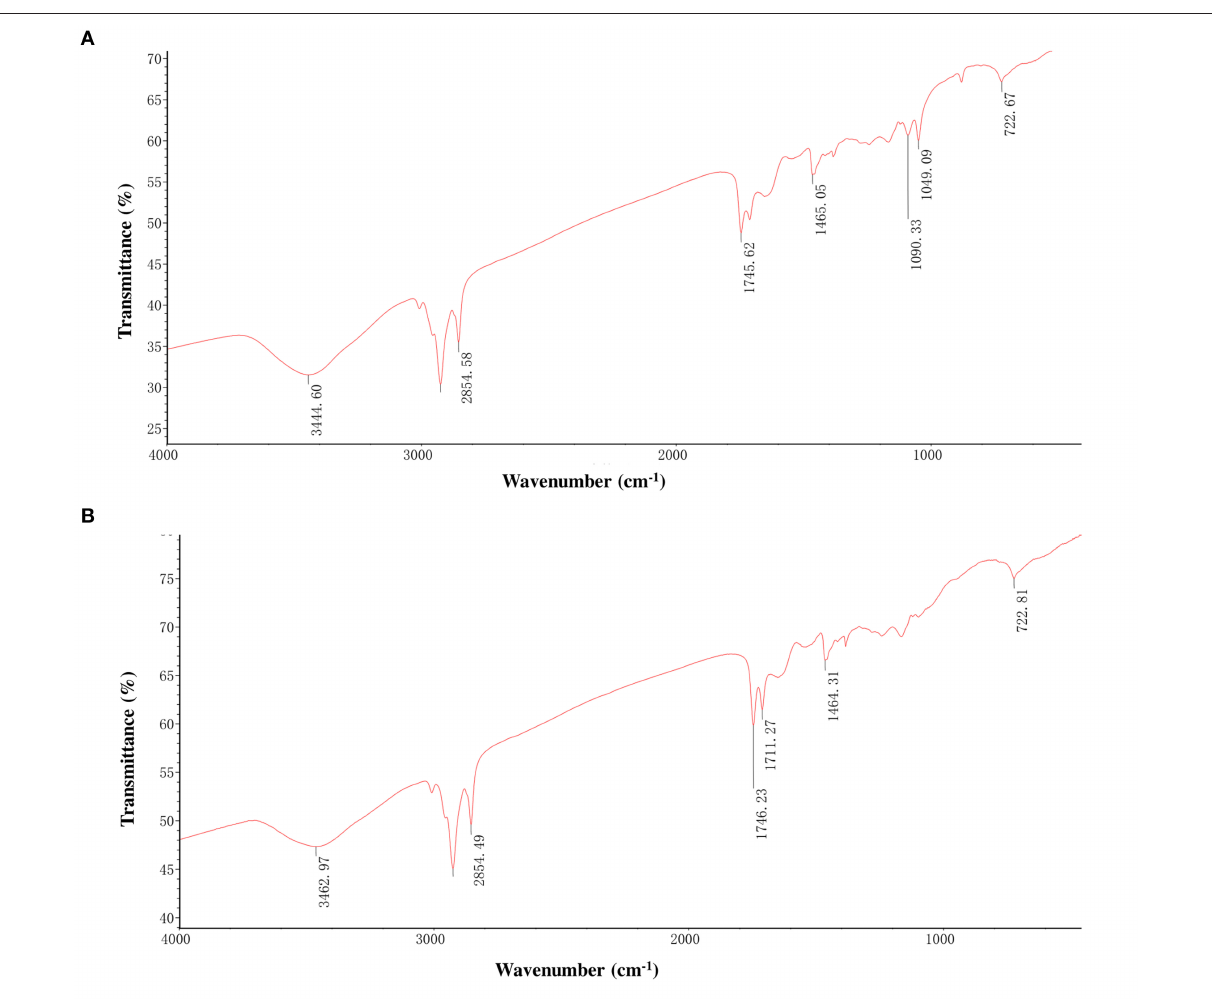
cm − 1 for the black and brown seeds melanin, respectively, corresponds to the OH group, and the peaks at ∼ 2,855 cm − 1 can be attributed to the stretching vibration of the aliphatic CH groups (14, 24, 26). The characteristic strong bands at ∼ 1,711– 1,745 cm − 1 can be assigned to C = O stretching (26). The absorption at 1,650–1,500 cm − 1 corresponds to the vibration of aromatic ring C = C bonds or stretching of the COOH and C-N groups, or the N-H deformation (24, 26, 32). The peaks at ∼ 1,465 cm − 1 are attributed to aliphatic C-H groups in the melanin pigment, and those at ∼ 1,090 cm − 1 are assigned to the COH stretching of phenolic compounds or aromatic rings in substituted macromolecular systems (24, 26, 33). The peak centered at 1,049 cm − 1 for the pigment extracted from the black sesame seeds indicates CH in-plane of aliphatic structure, which is also a characteristic of melanin pigment (24). The observed peaks at ∼ 722 cm − 1 can be attributed to out-of-plane bending of the aromatic C-H group